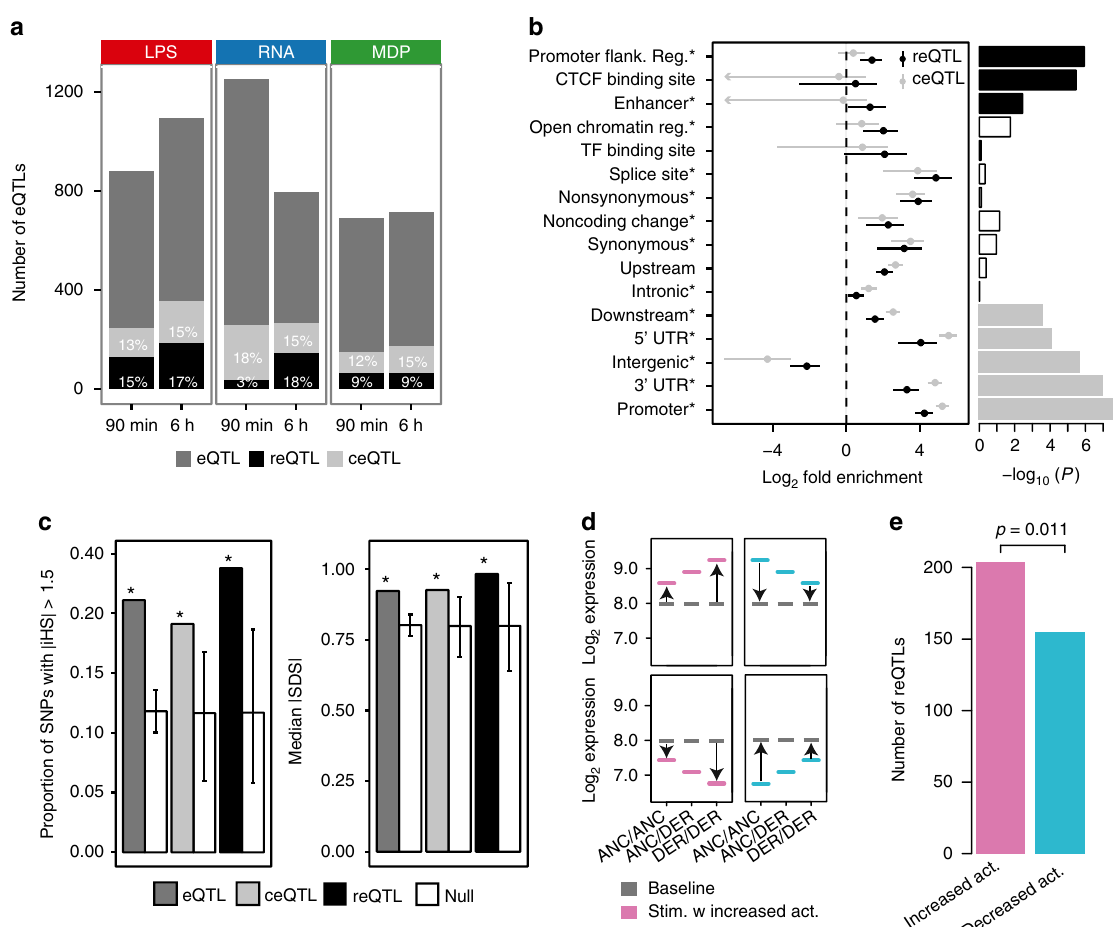
Fig. 3 Functional annotations and signs of natural selection in reQTLs. a Total numbers of cis eQTLs, and proportions of reQTLs and constant eQTLs (ceQTL) that have similar regression slopes across all conditions. Results of the analysis of 134 individuals are shown unless indicated otherwise. Examples of a ceQTL and reQTL are shown in Supplementary Fig. 8a. b Forest plot of enrichment estimates of reQTL and ceQTL signals for each functional annotation with 95% con fi dence intervals (see also Supplementary Fig. 5b). Asterisks indicate annotations that improved the model likelihood in a stepwise procedure for the fi nal best- fi tting model. Bar plot shows the enrichment of the single most likely causal SNP per locus after fi ne mapping. The solid bars indicate signi fi cant enrichments after Bonferroni correction. c Signal of positive selection measured as the proportion of variants with high | iHS | ( left panel ), and median | SDS | ( right panel ), using the variant with the maximum value from each locus across all SNPs in high LD ( r 2 > 0.8). Genome-wide null sets of variants matched to eQTL, ceQTL or reQTL were generated by resampling 10,000 sets of random SNPs that matched for MAF and LD ( white bars ). Error bars indicate minimum and maximum of the null distribution, and asterisks indicate the signi fi cant enrichment compared to the null (permutation test p < 10 − 4 ). d Illustration of reQTLs where the derived allele causes an increase ( left panel ) or decrease ( right panel ) in response amplitude compared to the ancestral allele. The increase or decrease of the response amplitude can be in both directions, e.g., reQTLs that amplify the induction or amplify the suppression of a gene are both considered as reQTLs with “ increasing activity ” of the derived allele and reQTLs that weaken the induction or suppression of a gene are both considered as reQTLs with “ decreasing activity ” of the derived allele. e Numbers of reQTLs with increased or decreased activity across all stimulated conditions, with a p -value from a binomial